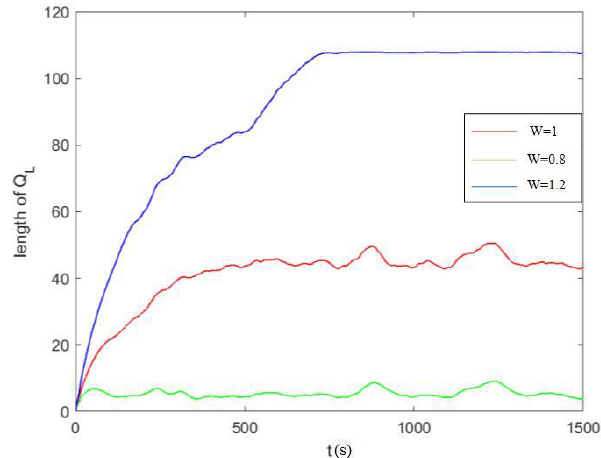
Figure 7. Comparison of high-priority queue lengths under different packet arrival rates.